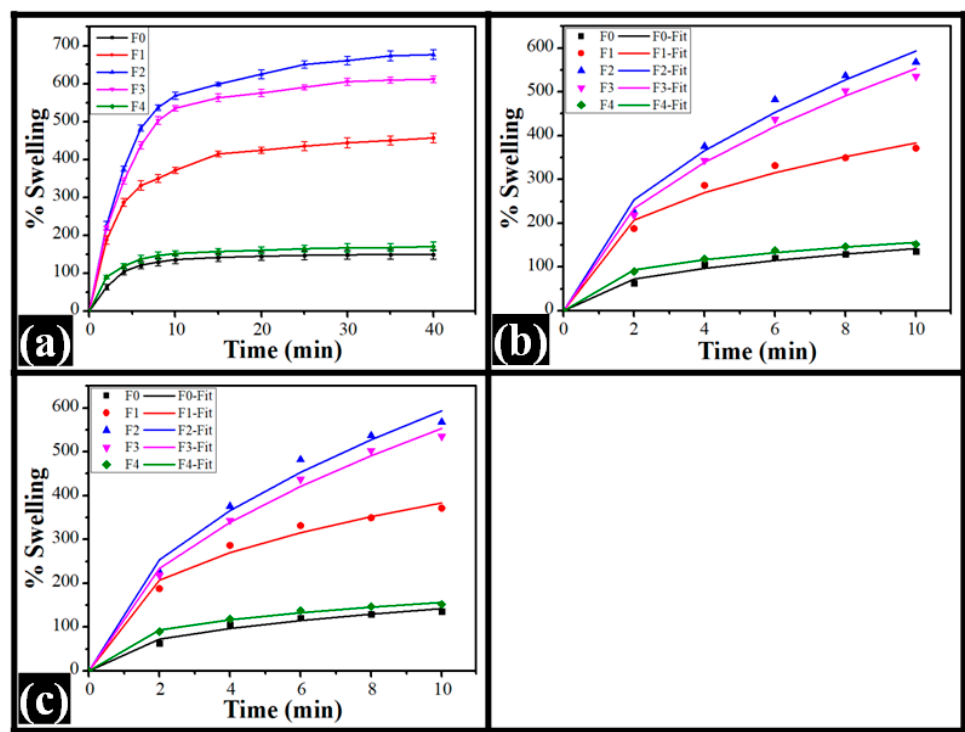
Figure 4. Swelling analysis: ( a ) Representation of %swelling profiles of the films, model fitting ( b ) Korsmeyer–Peppas, and ( c ) Peppas–Sahlin. Table 1. Swelling parameters of the composite films.